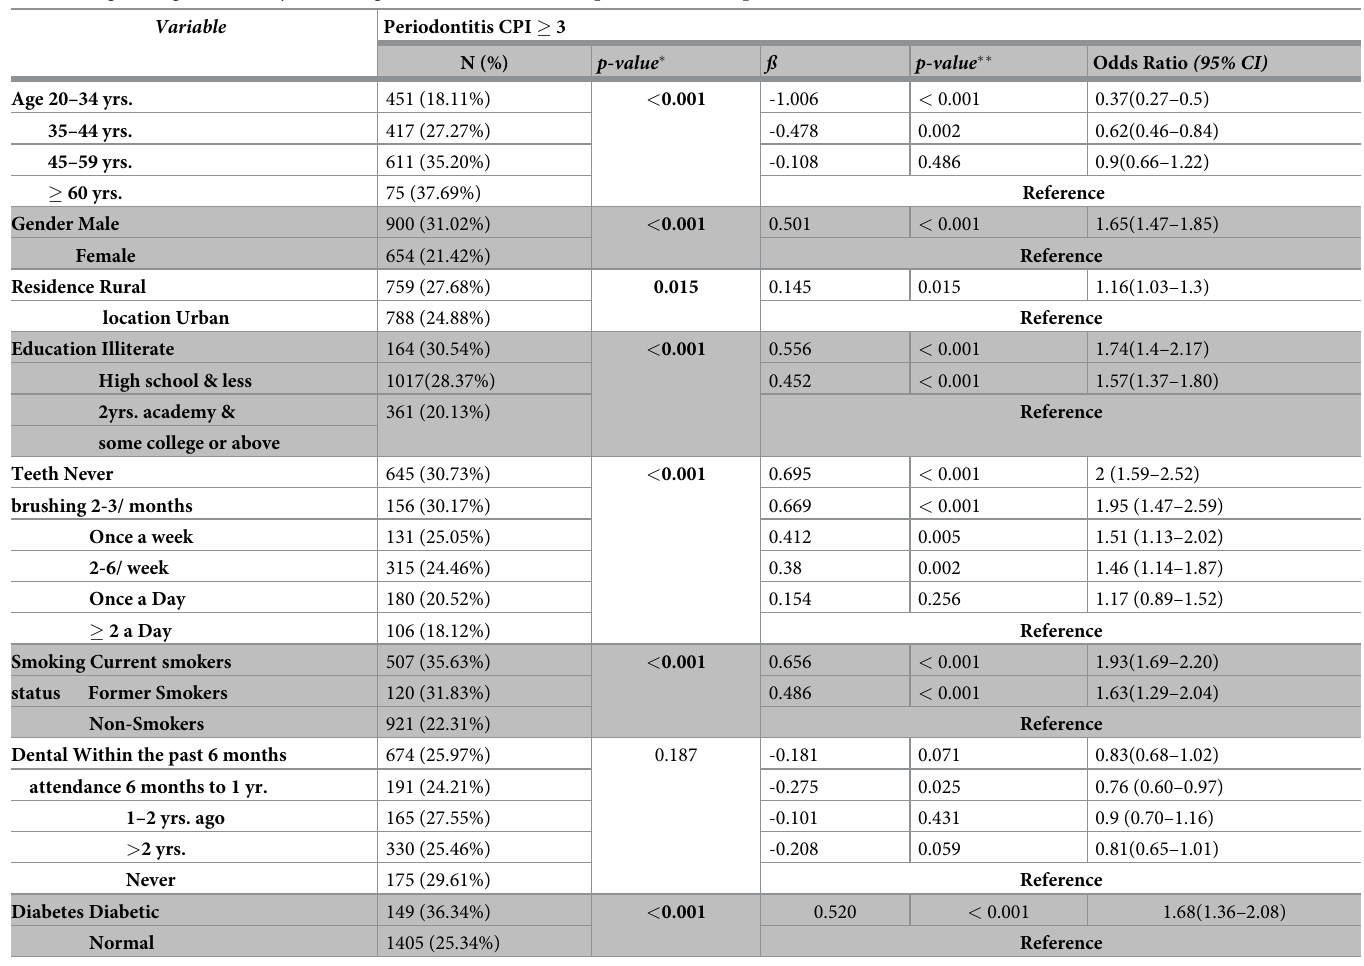
Table 2. Logistic regression analysis showing the associations between periodontitis and potential risk